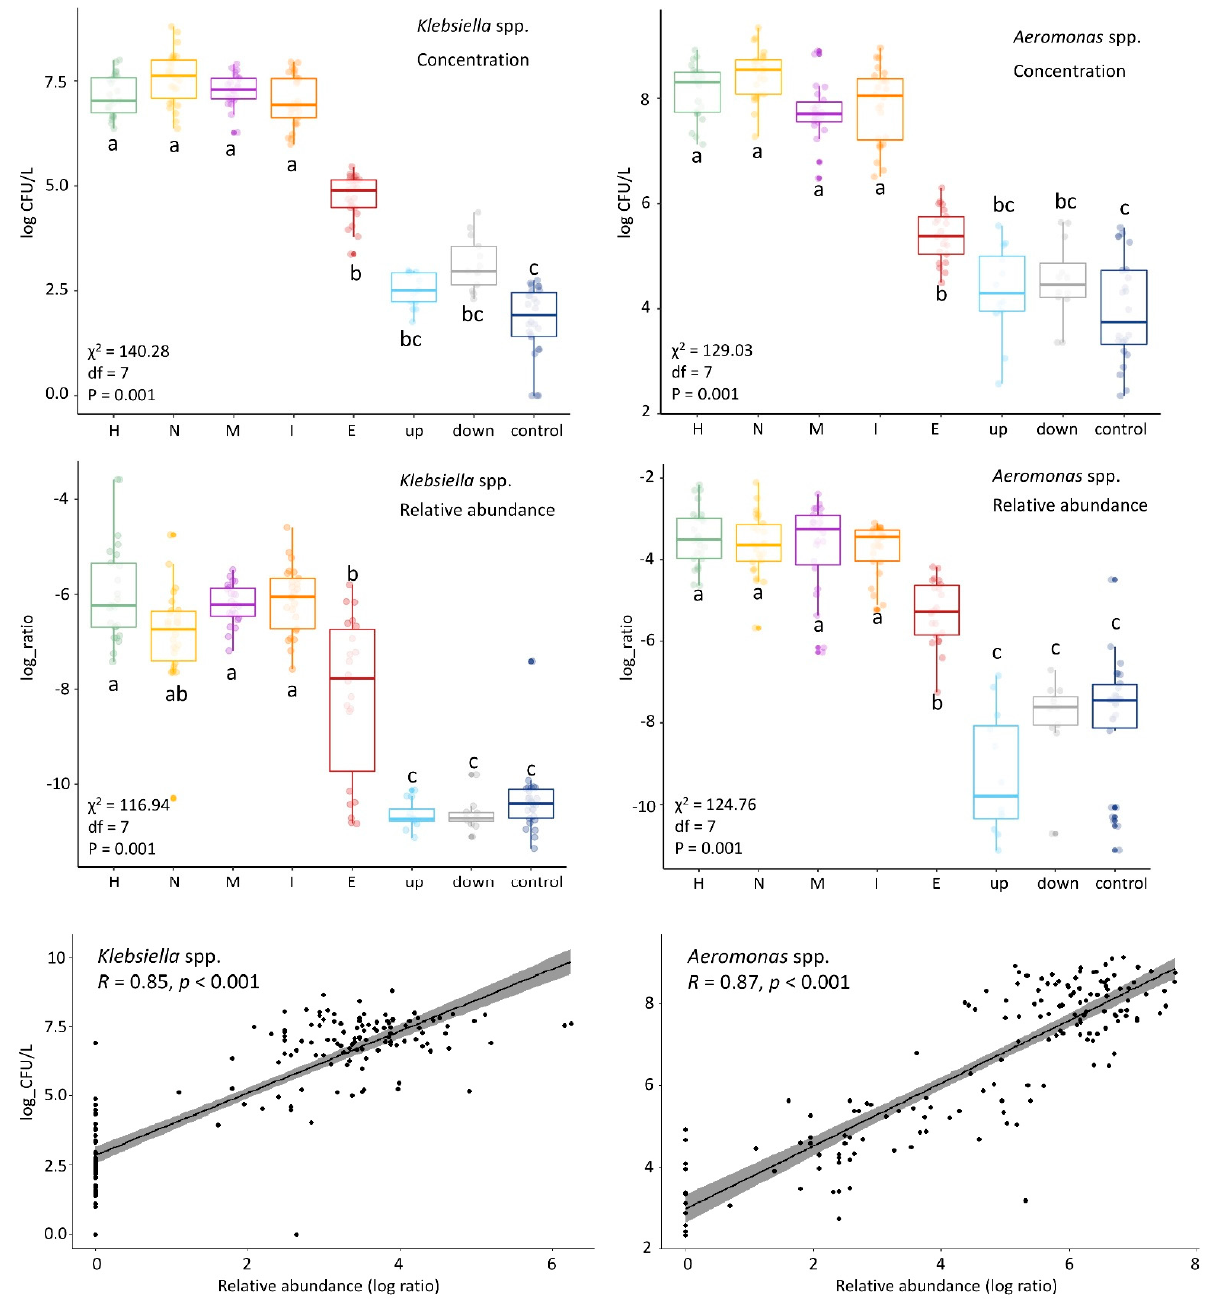
Figure 4. Comparison of colony forming units (CFU) counts and relative abundances in the different locations of Klebsiella spp. (left) and Aeromonas spp. (right). The CFU counts (log(CFU/L) and relative abundance (log ratio) show similar patterns along the locations. This was confirmed by Pearson correlation analysis (R) shown in the linear regression curves. Kruskal-Wallis statistics of the CFU counts and relative abundances are shown on the left side of each panel: chi-squared ( χ 2 ), df and p-value). Group differences were assessed by the Dunn’s test with the p-value adjustment method: BH. The locations are shown on the horizontal axis. H = hospital, N = nursing home, C = community (municipal wastewater), I = influent, E = effluent, up = upstream surface water, down = downstream surface water, and control = surface water collected at nature reserve “de Deelen”.